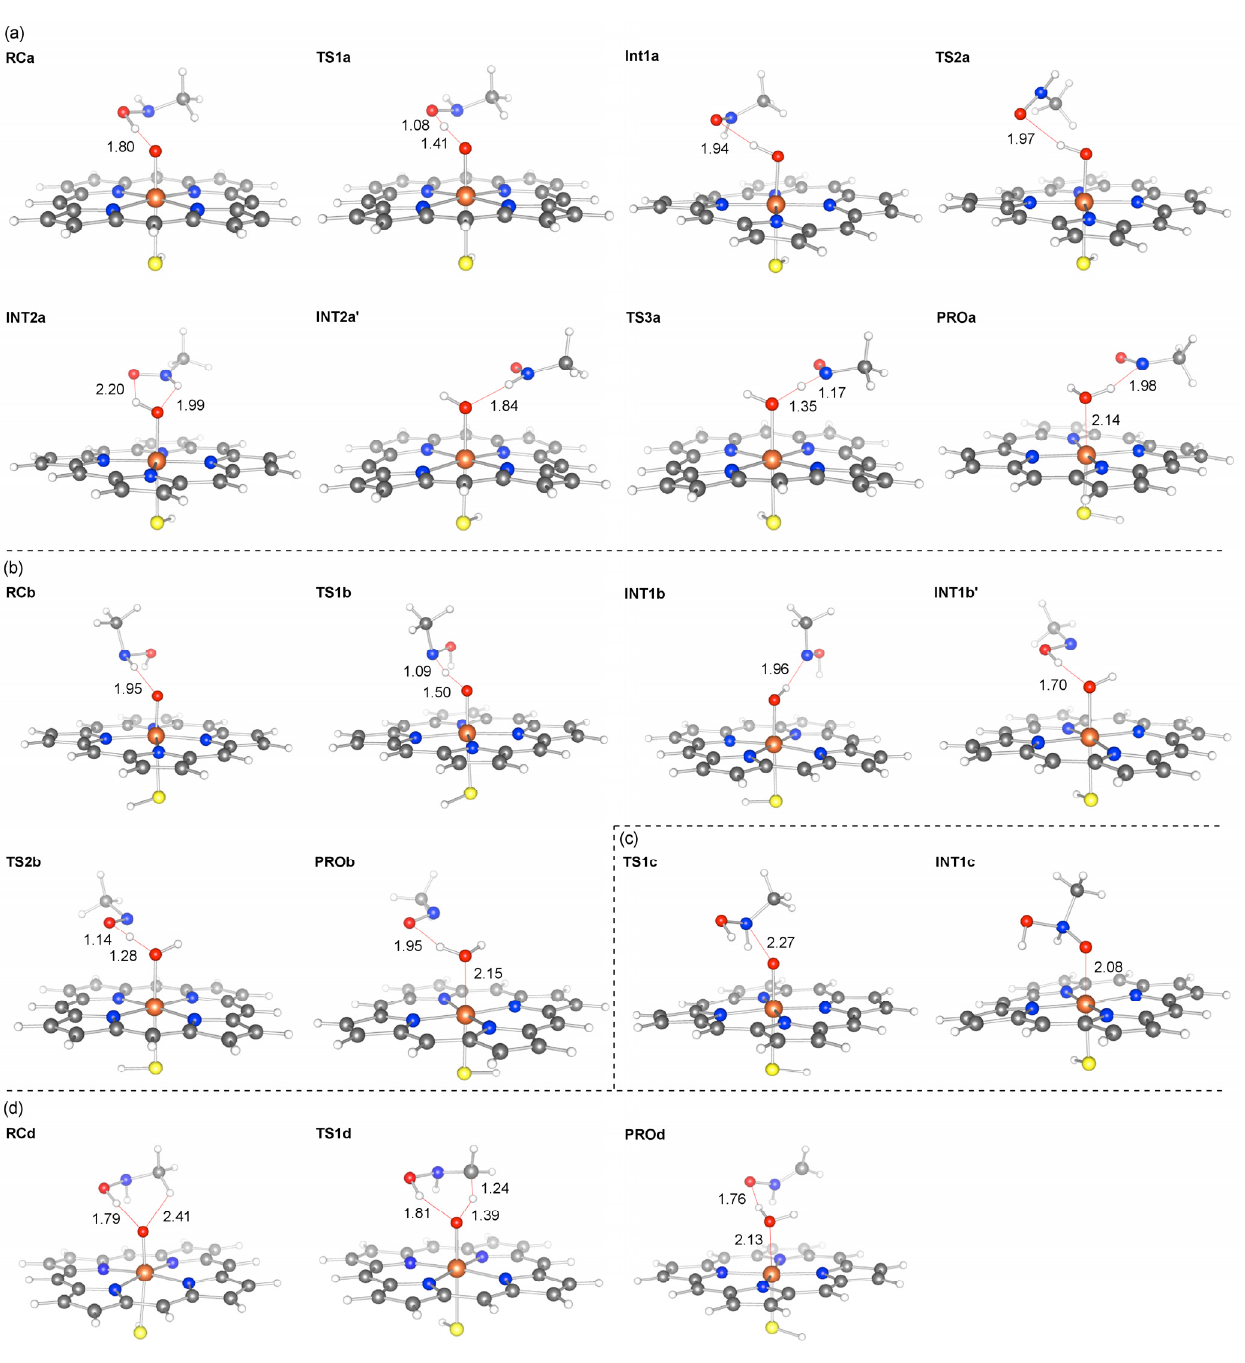
Figure 2. Optimized geometries of species on ( a ) path A; ( b ) path B; ( c ) path C; and ( d ) path D. Key bond distances are shown in